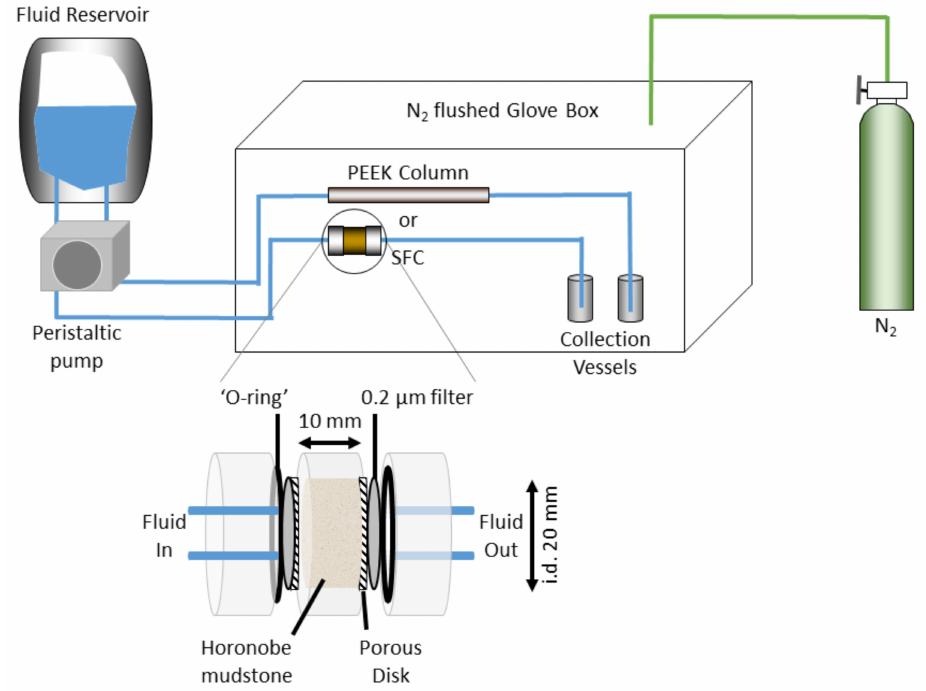
Figure 1. Schematic of flow set-up, with inset detail of small flow cell (SFC). Note: ‘O-rings’, porous disks, and filters were fitted to both sides of the